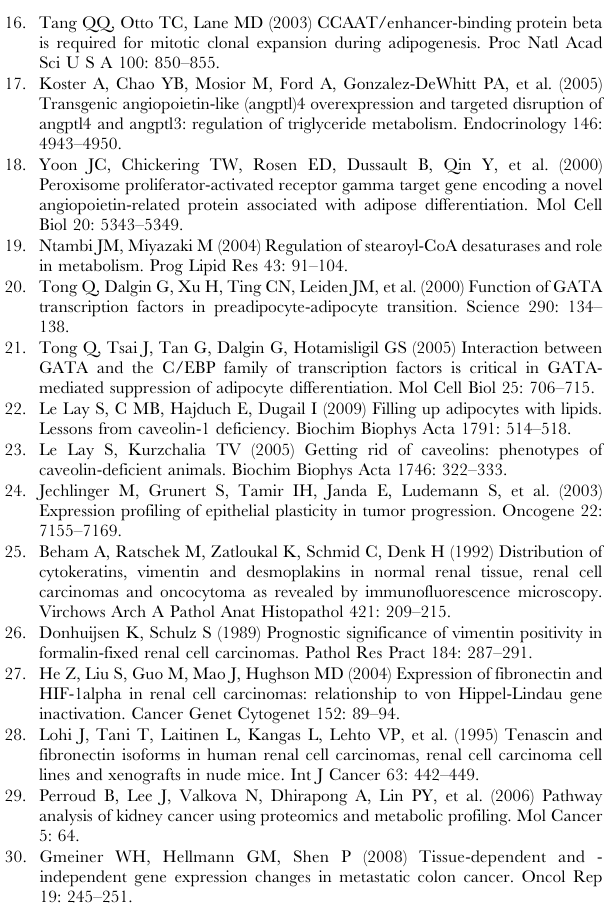
Table S1 Table of primers used in TILDA qPCR. KPNA6, POLR2A and UBC were used as internal controls. Figure S1 Renal developmental genes are down-regulated in ccRCC. The large heatmap shows differential expression of transcription factors between ccRCC and normal renal samples. The smaller heatmap highlights clustering of down-regulated renal developmental transcription factors (GATA3, TFAP2B, DMRT2, and TFCP2L1) in a subcluster. Upregulation of genes is indicated in red, downregulation is indicated in green, and a similar expression is indicated in black, as generated by Cluster 3.0. Figure S2 An adipogenic gene expression signature of ccRCC is elucidated. Normal denotes normal renal samples. Gene expres- sion data are from a publicly available database, GSE # 15641, deposited at Gene Expression Omnibus (GEO). Details on the